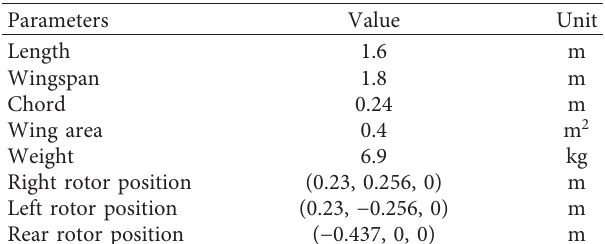
Table 1: Specifications of the